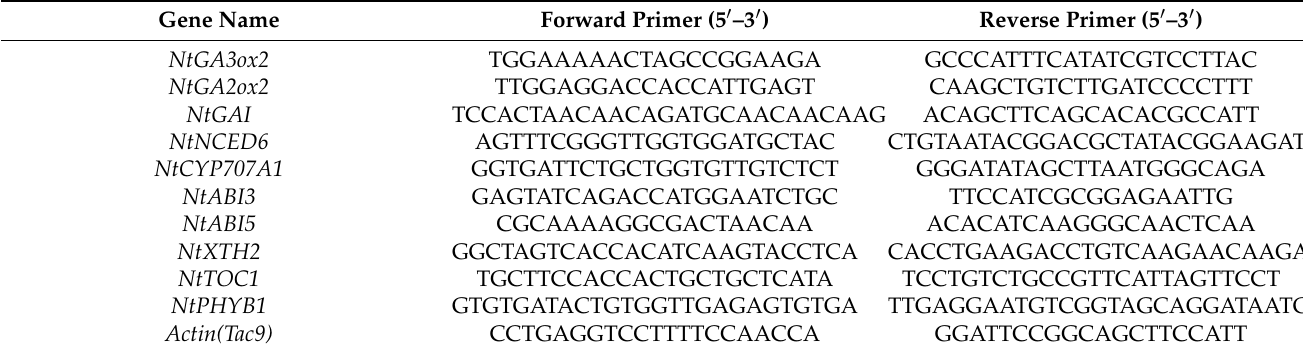
Table 1. Real-time PCR primers used for genes expression